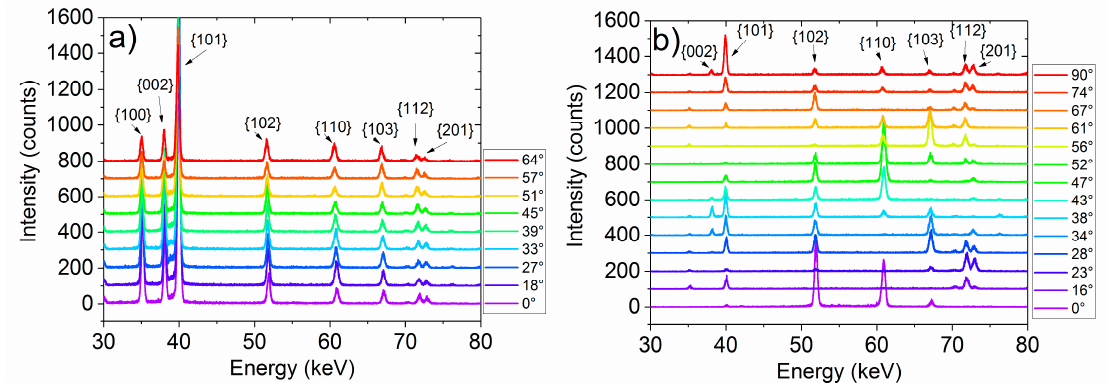
Figure 3. Diffractograms for sin 2 ψ tilts of A4 sample in ( a ) reflection (at subsurface), ( b ) transmission (in bulk). Note: the ψ -tilt angles are indicated in the insets.